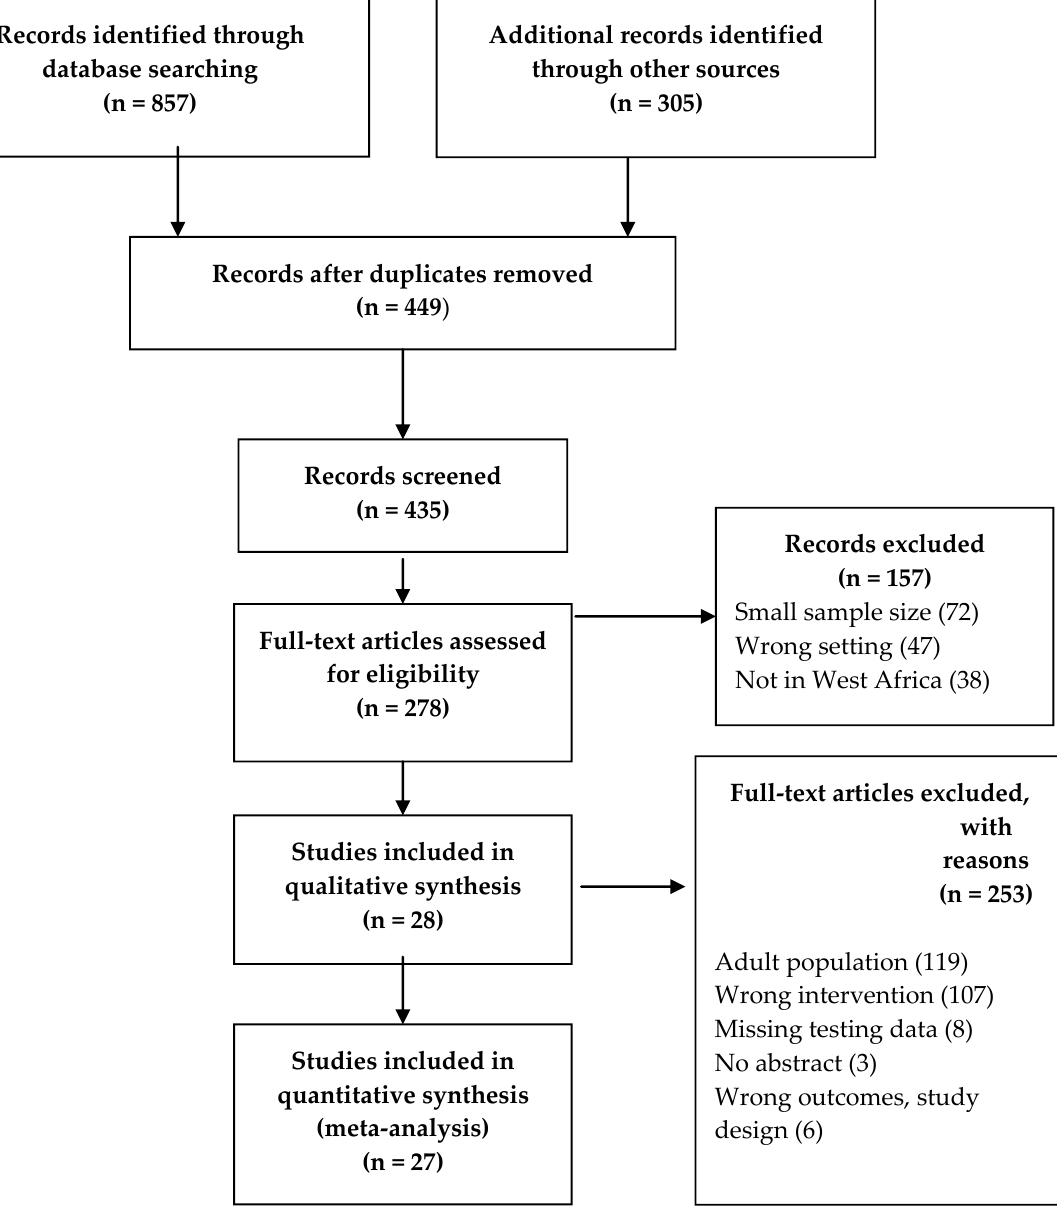
Figure 1. Study Eligibility Flow Diagram.